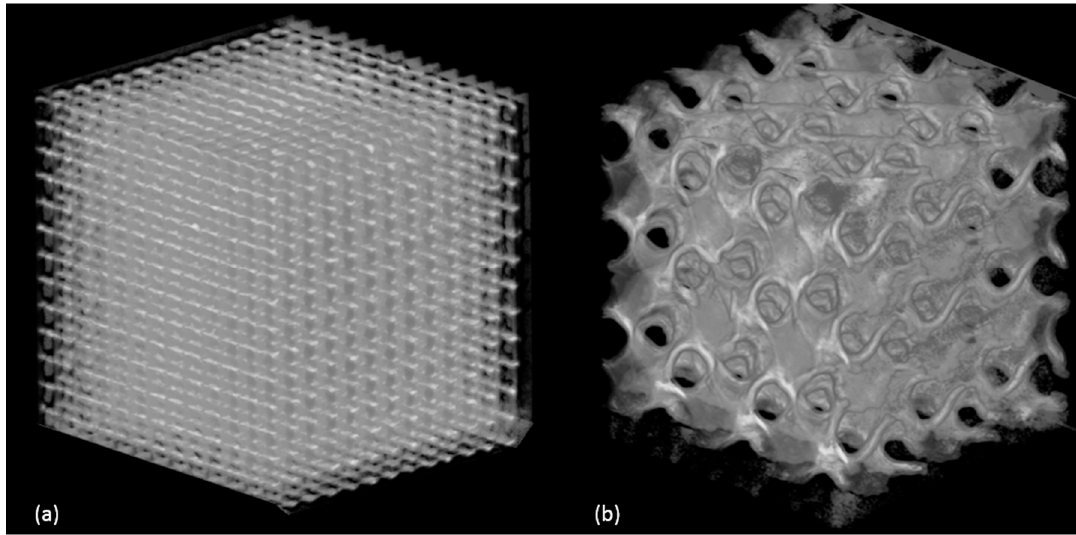
Figure 6. CT reconstruction of samples: ( a ) cube; and ( b ) gyroid.